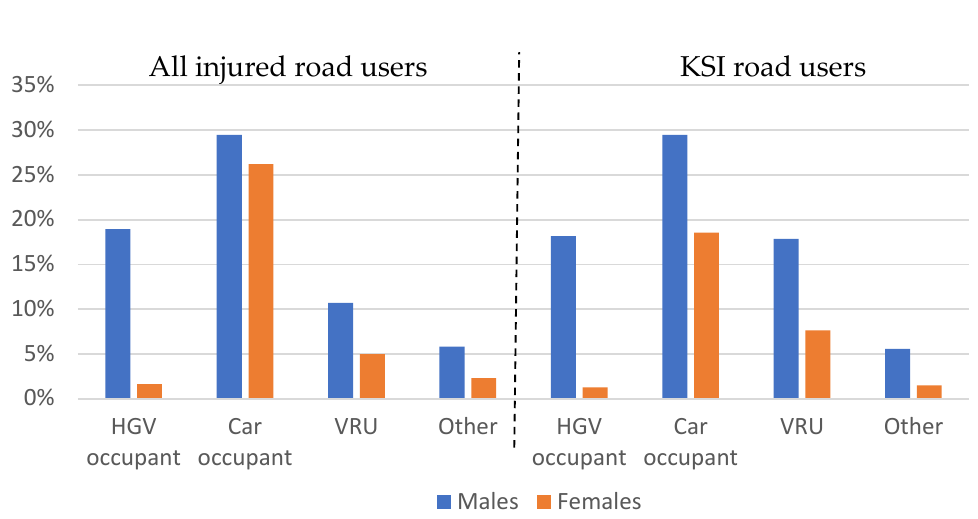
Figure 5. Joint distribution of gender and road user group for people injured in crashes with HGV involvement in EU-28, separately for all injury levels and for KSI, based on CARE data .